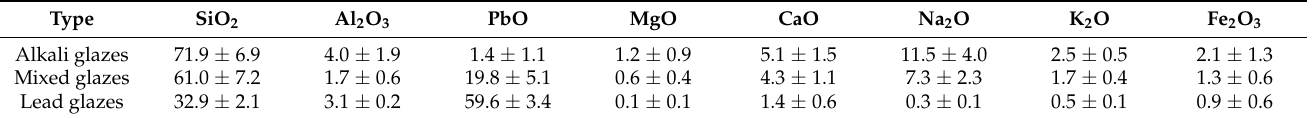
Table 1. Main oxide wt% average of glaze types with standard deviation for the three groups based on the results by Gradmann [12].